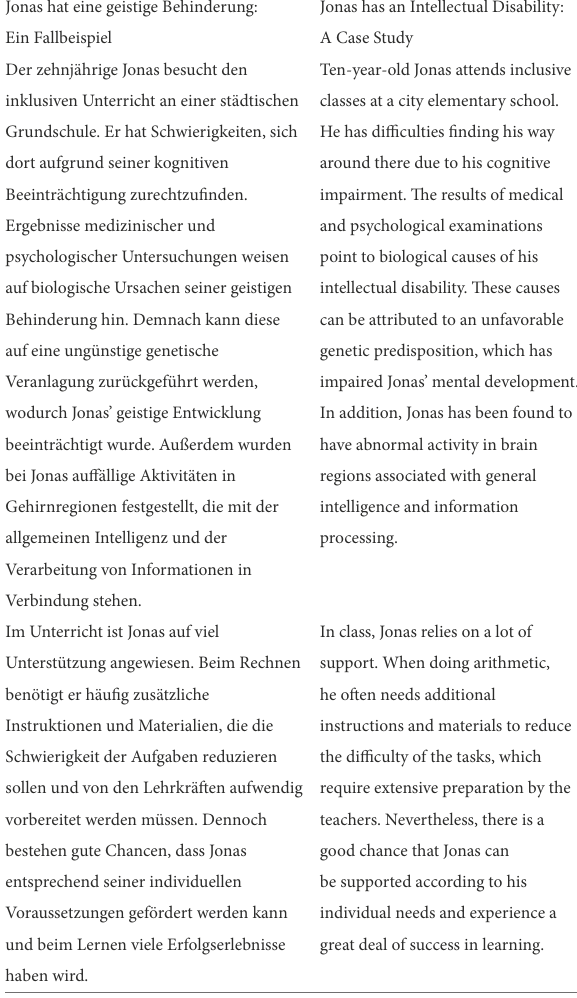
TABLE 2 Original German stimulus text from Figure 2 and its English translation (manipulations: type of disability: intellectual disability; sex: male; attributed cause: biological; need for support: high; chance of learning success: high). Original German stimulus text English